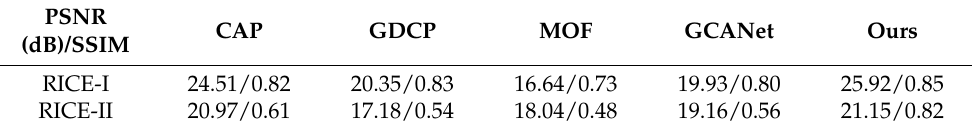
Figure 7. Results of the RICE-II dataset for cloud removal.